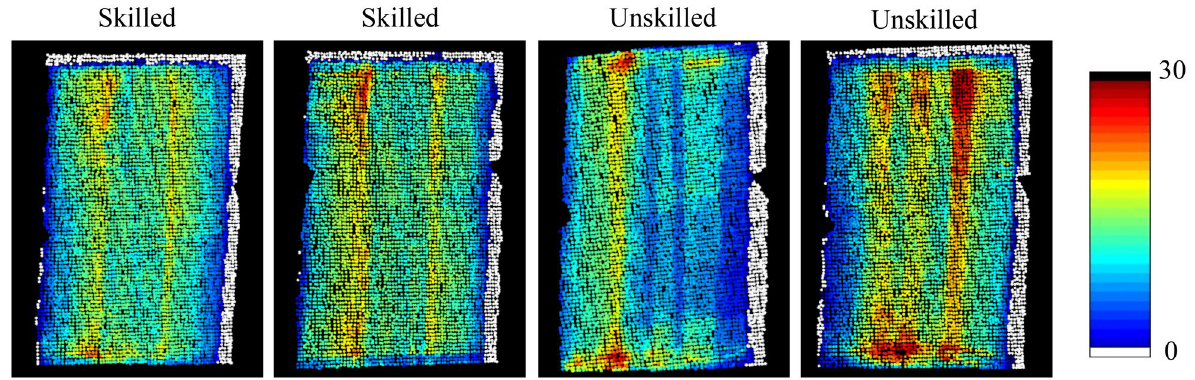
Fig. 14 Examples of swept maps